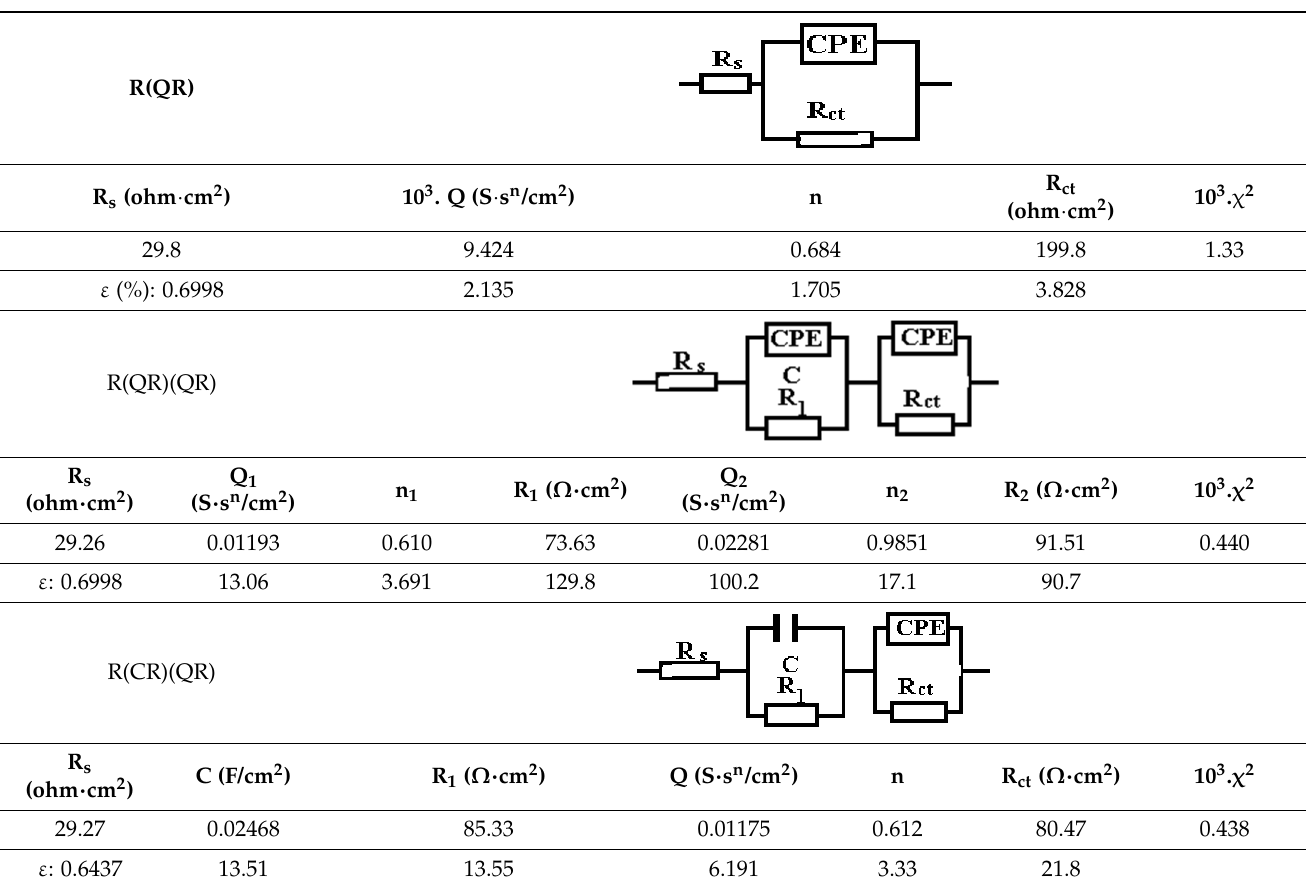
differences could be attributed to large errors in the evaluation of the parameters with the R (QR) (QR) circuit. In the Nyquist diagram, the experimental curve shows a negative loop in the low frequency range. This distortion is most often attributed to an inductive behavior of the electrochemical system due to the process of adsorption of intermediates on the surface of the electrode (sample). Here, it would most likely be adsorption of Fe or Fe 2 O 3 . For data simulation, it is necessary to use an equivalent circuit with inductance (Figure 8).